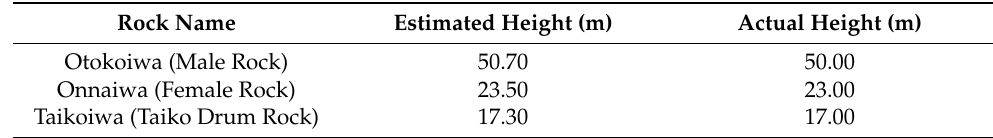
Table 1. Comparison of rocks heights estimated by the 3D model and actual geological survey.